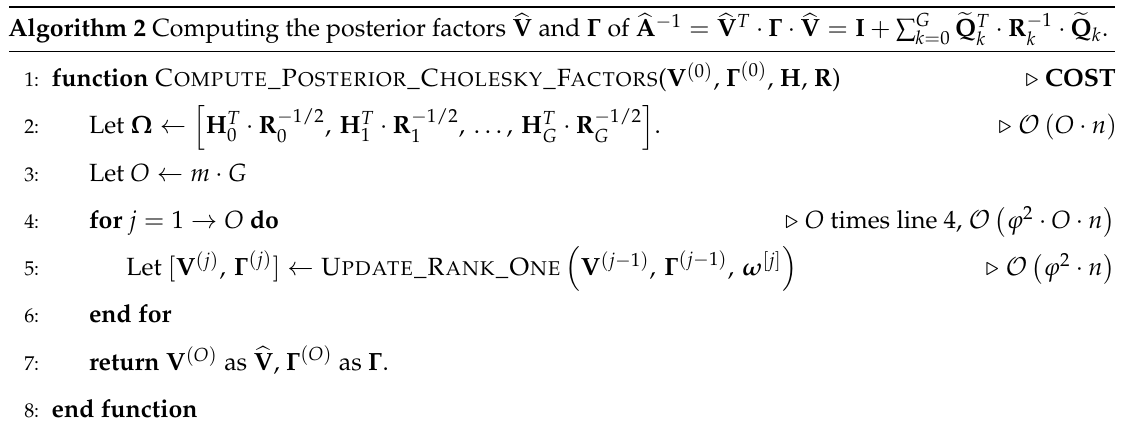
Algorithm 2 Computing the posterior factors (cid:98) V and Γ of (cid:98) A − 1 = (cid:98) V T · Γ · (cid:98) V = I + ∑ G